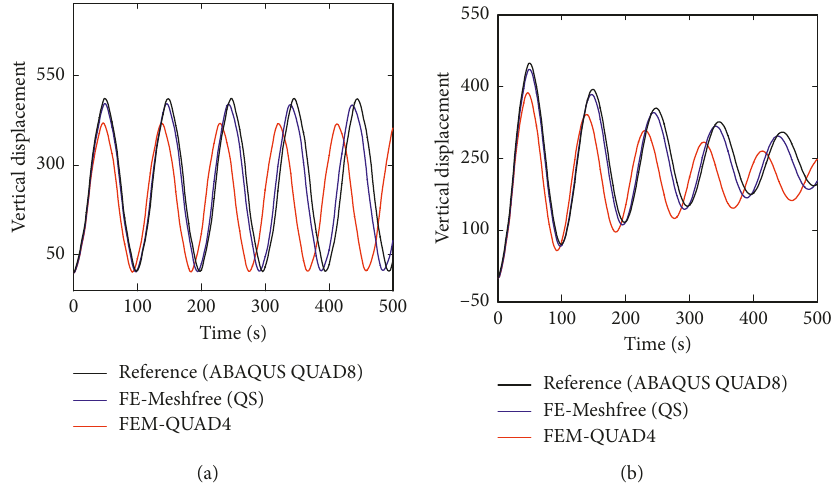
. 05: (a) without damping; (b) with damping. f (cid:31) 0